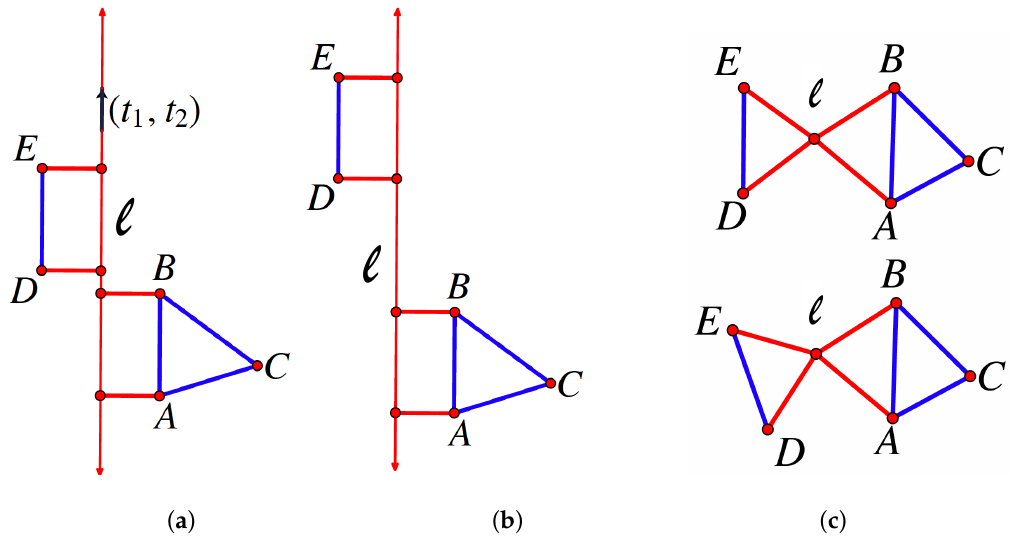
Figure 15. A slider joining two bodies ( a , b ). After a projective transformation, this is two bodies in the plane, joined by a single vertex ( c ). The translation becomes a rotation as indicated in ( c